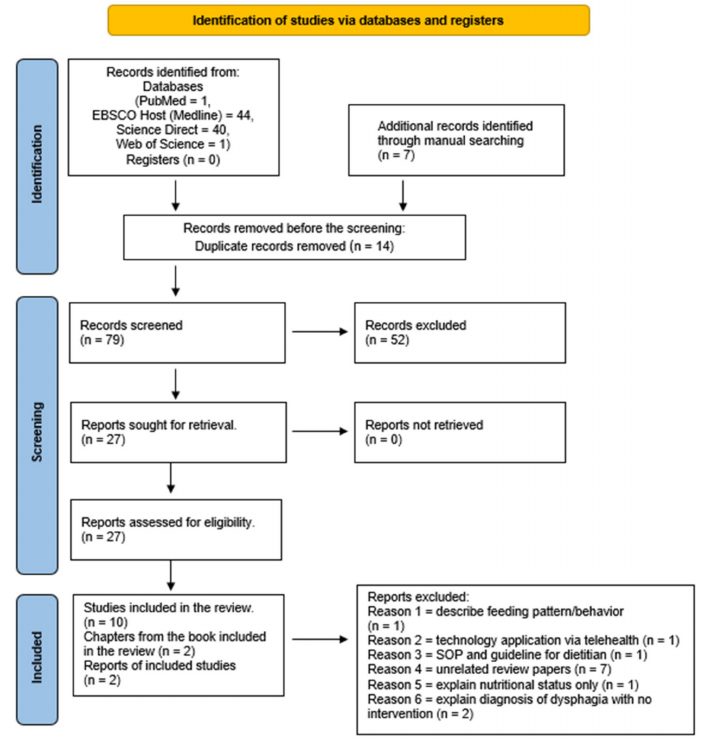
Figure 1. PRISMA-SCR 2020 Flow